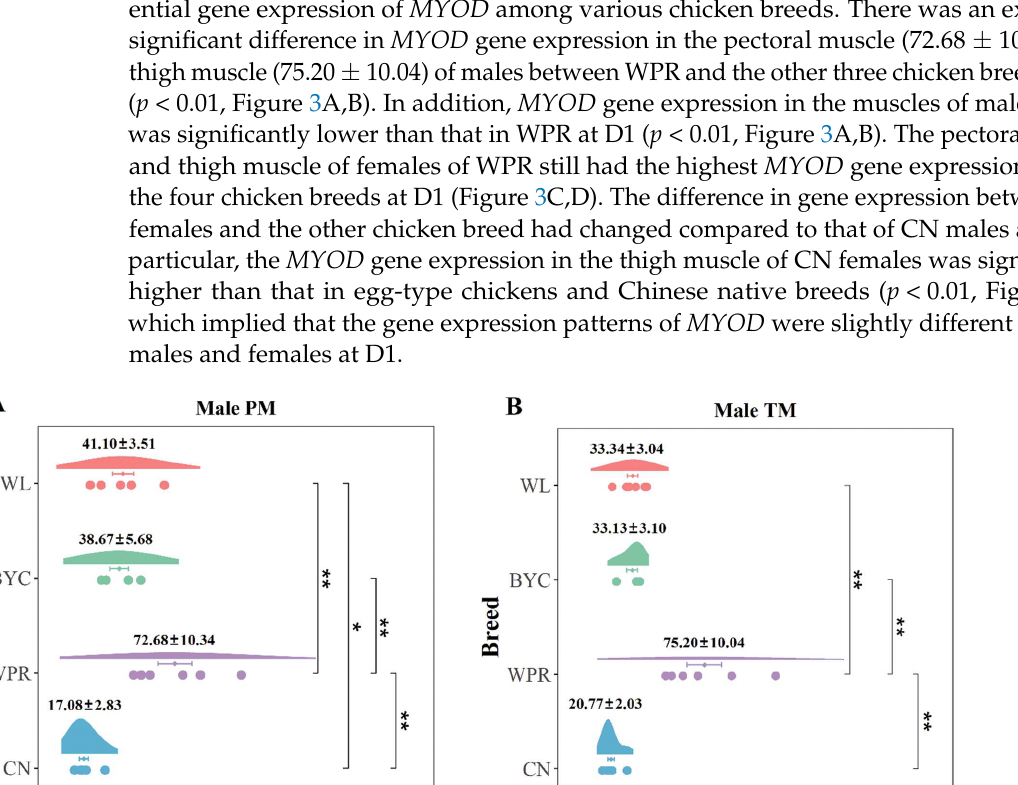
Figure 3. Gene expression of MYOD among the various chicken breeds at D1. ( A ) Gene expression differences of MYOD in the PMM among the four chicken breeds at D1. ( B ) Gene expression differ- ences of MYOD in the TMM among the four chicken breeds at D1. ( C ) Gene expression differences of MYOD in the PMF among the four chicken breeds at D1. ( D ) Gene expression differences of MYOD in the TMF among the four chicken breeds at D1. ** and * represent adjusted p values < 0.01 and < 0.05, respectively. 2.4. Inhibition of MSTN for the Myoblast Fusion The expression level of the MSTN gene was low during the critical period of myoblast fusion, while it reached the highest level at E17, at which time the myofiber development of chicken embryos was repressed. The gene expression of MSTN in the pectoral muscle of BYC males (23.10 ± 0.95) was significantly higher than that of WL and WPR males at E17 ( p < 0.01, Figure 4A). Similar results were obtained in the thigh muscle of BYC males